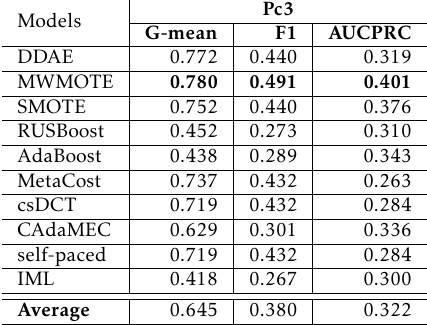
Table 21. Overall Results for Pc3 Dataset